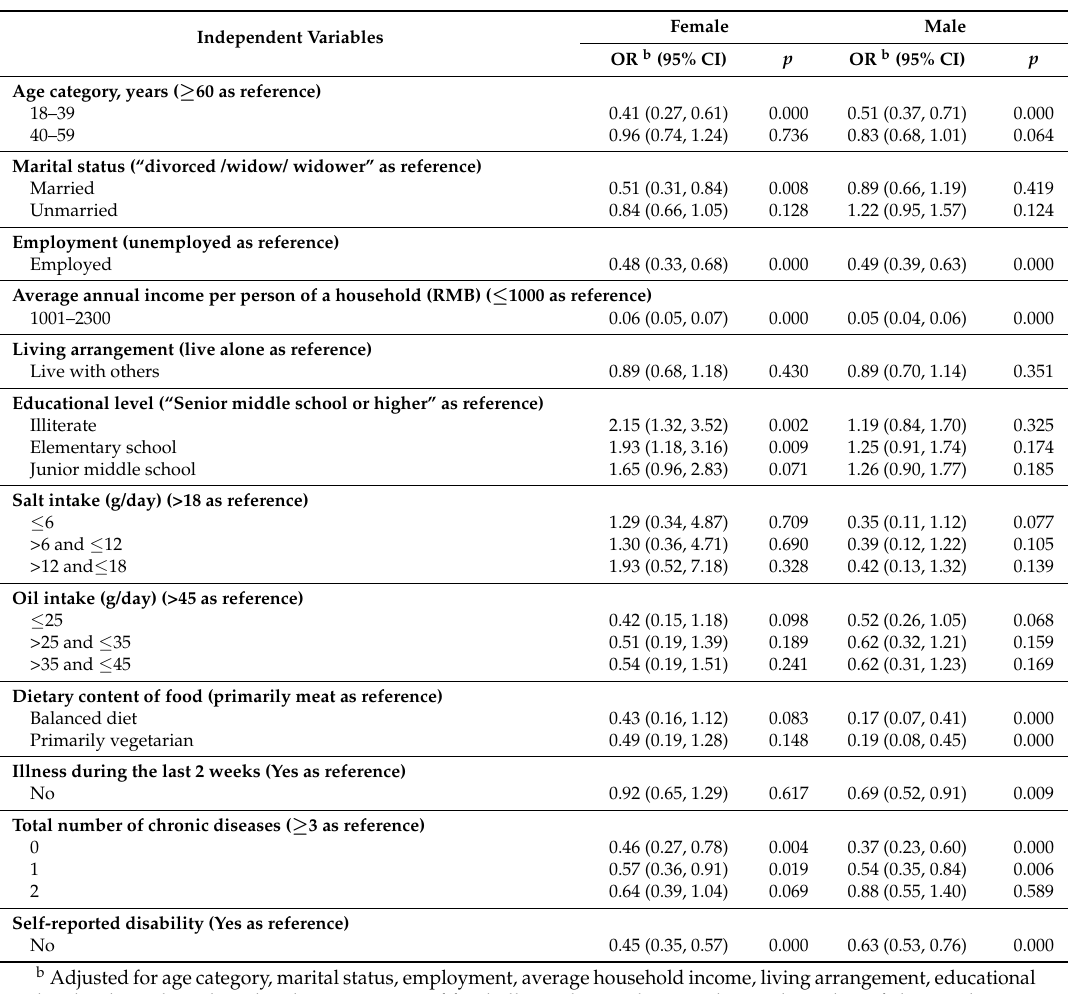
Table 5. Adjusted associated factors of poor sleep quality by